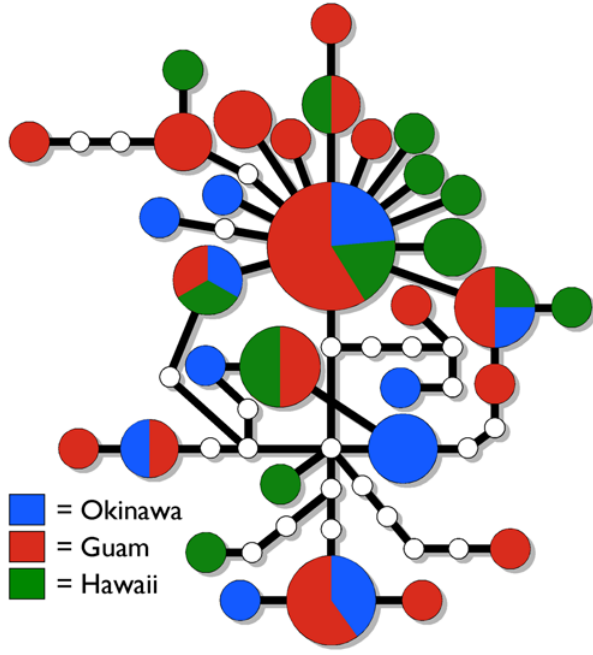
Figure 3. Haplotype network of COI sequences from 67 individuals of Conus ebraeus at Okinawa, Guam and Hawaii. Haplotypes are illustrated as circles, with hypothetical haplotypes that were not observed illustrated as small, empty circles. Areas of circles are proportional to the haplotype frequencies; pie diagrams illustrate frequencies of haplotypes at each